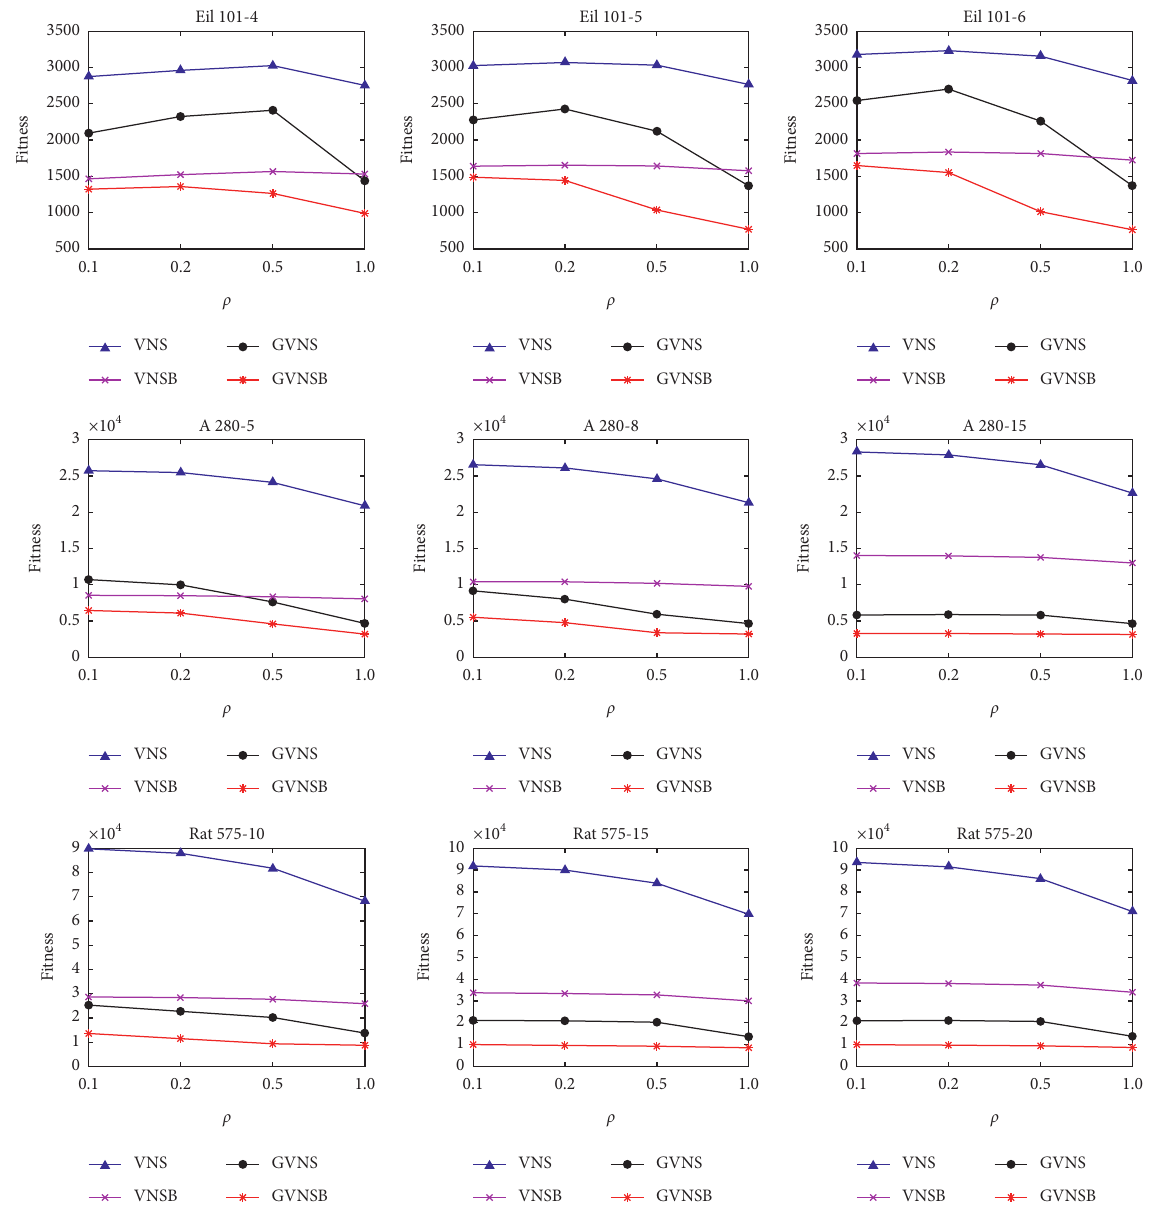
Figure 7: The results of VNSs in the environment with τ �